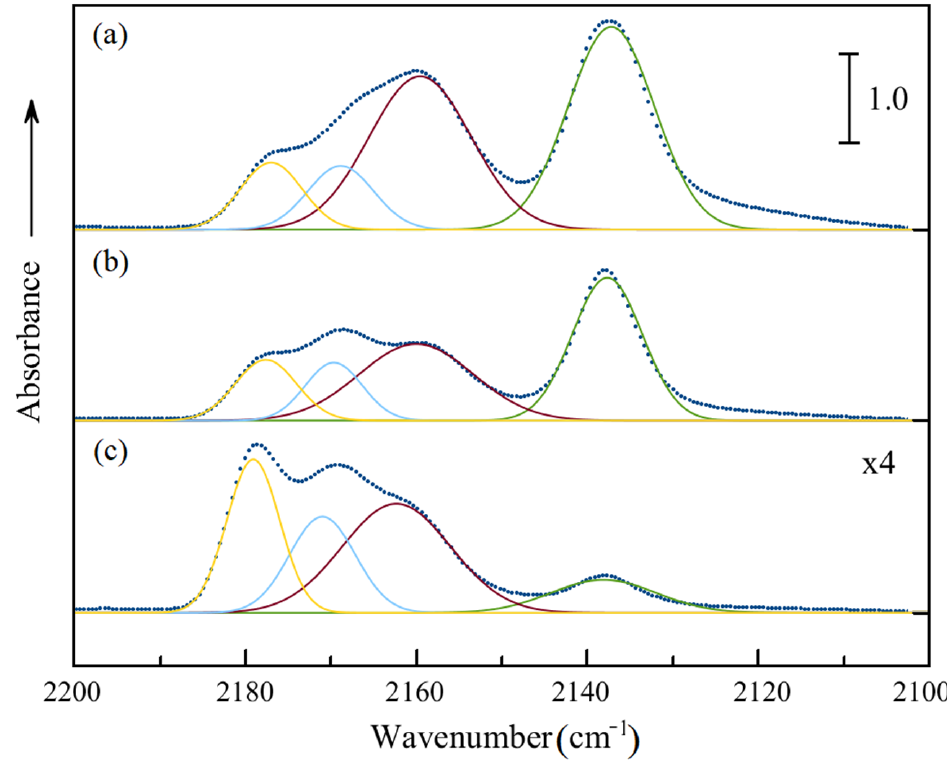
Figure 10. FTIR spectrum of CO adsorbed on HMOR-18.7 pretreated at 300 ◦ C registered at − 196 ◦ C for three successively diminishing coverages ( a – c ) and the results of their deconvolution (the parameters of the spectra deconvolution are given in the Supplementary Materials, Table S2). Approximate positions of the four maxima are 2178, 2170, 2160, and 2138 cm − 1 . Obtained in this way, intensities of the bands related to the thickness of samples in mg/cm 2 for CO adsorbed on different sites of the studied samples are presented in Table 5. From these figures, using the known values of integrated extinction coefficient ε we can easily estimate the concentration of corresponding surface sites. There are some contradic- tions about the values of ε for adsorbed CO [69,70]. Here, we use values from [69], where it was measured for molecules adsorbed on silanol groups of aerosil ( ε = 1.6 cm/ µ mol) and on hydroxyls of HZSM-5 zeolite ( ε =2.1 cm/ µ mol). For CO adsorbed on aluminum cations we take a value of ε = 0.2 cm/ µ mol, obtained for strong Lewis sites of TiO 2 , for which the frequency of adsorbed molecules (2210 cm − 1 ) is the nearest to that of CO interacting with Al 3+ in our case (2225–2206 cm − 1 ). Here, we give in the table for H-MOR-18.7 the sum of intensities of two bands at these wavenumbers. Recently, the integrated extinction coefficient ε was determined for the stretching OH bands of silanols and bridged Si-OH-Al groups of H-ZSM-5 and H-ZSM-23 zeolites from the comparison of band intensities in